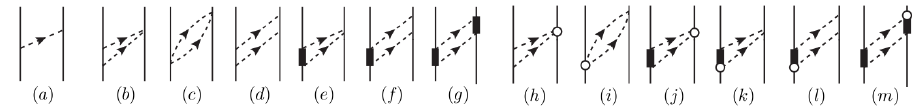
Figure 1. OPE and TPE contributions at LO [(a)], NLO [(b)–(g)], and N2LO [(h)–(m)]. Nucleons, Δ isobars, and pions are denoted, respectively, by the solid, thick-solid, and dashed lines; both direct and crossed box contributions are retained in diagrams (d), (f)–(g), (l)–(m). The open circles denote π N and π N Δ couplings from the sub-leading chiral Lagrangians L (2) [8] and L (2) [9]. π N π N Δ